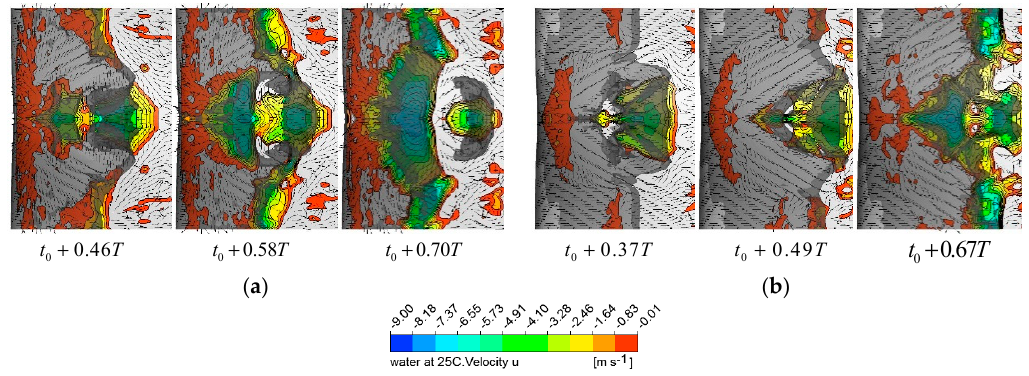
Figure 8. The velocity vector, the contour of the u -velocity component, and the iso-surface of the water vapor volume fraction on the suction side of the hydrofoils in top view: ( a ) NACA0009; and ( b ) Clark-y.